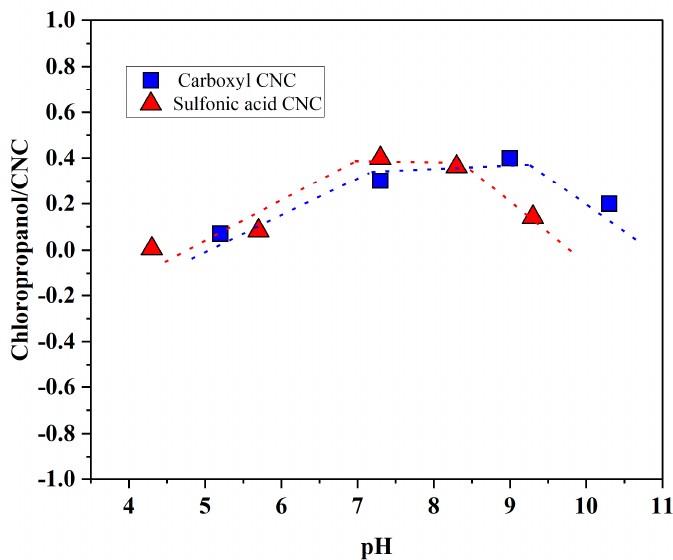
Figure 6. The effect of pH on the adsorption of chloropropanol on CNC.